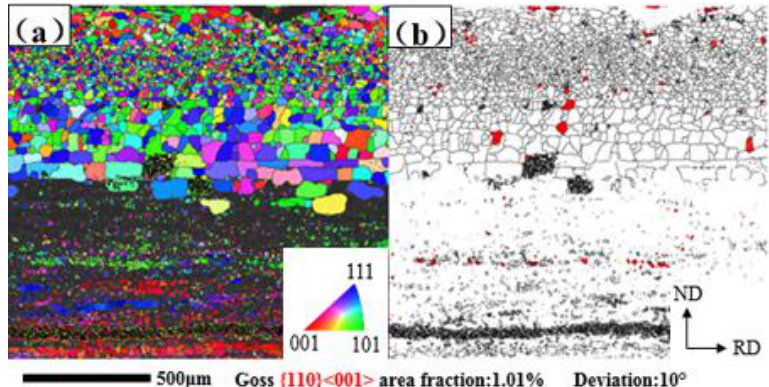
boundary to 1/6 thickness of the sample, the subsurface region is 1/6~1/3 thickness and the center region is 1/3~1/2 thickness of the sample (all specimens followed are the same). It can be seen that Goss texture still exists mainly on the subsurface. In addition, the quantity of Goss texture in three specimens is 1.01%, 0.824%, 1.49%.